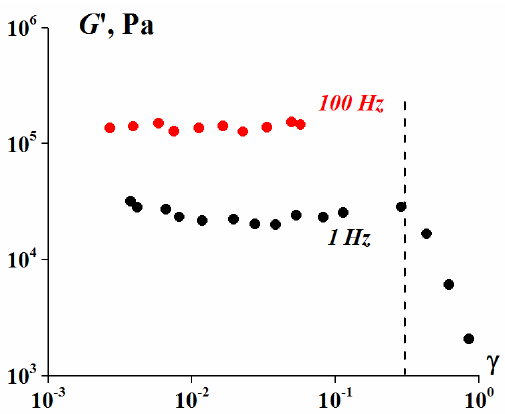
Figure 6. The strain dependence of the storage modulus of the 75 vol. % bimodal suspension ( λ = 9.4, 25% content of smaller particles).